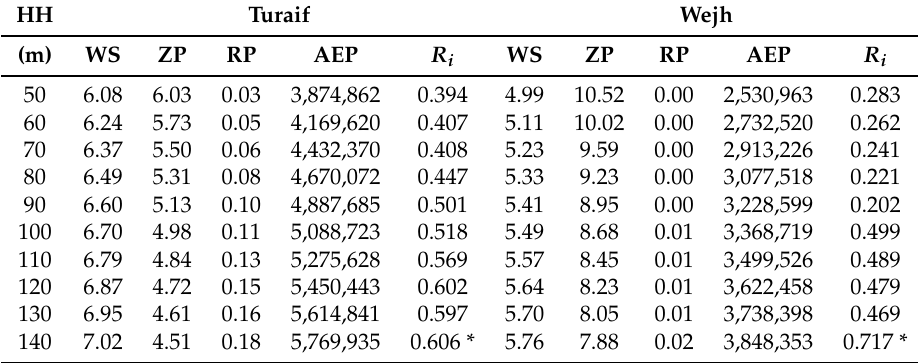
Table A7. TOPSIS analysis for turbine Enercon E-82 E4/3000. The best choice for each site is marked with an asterisk.